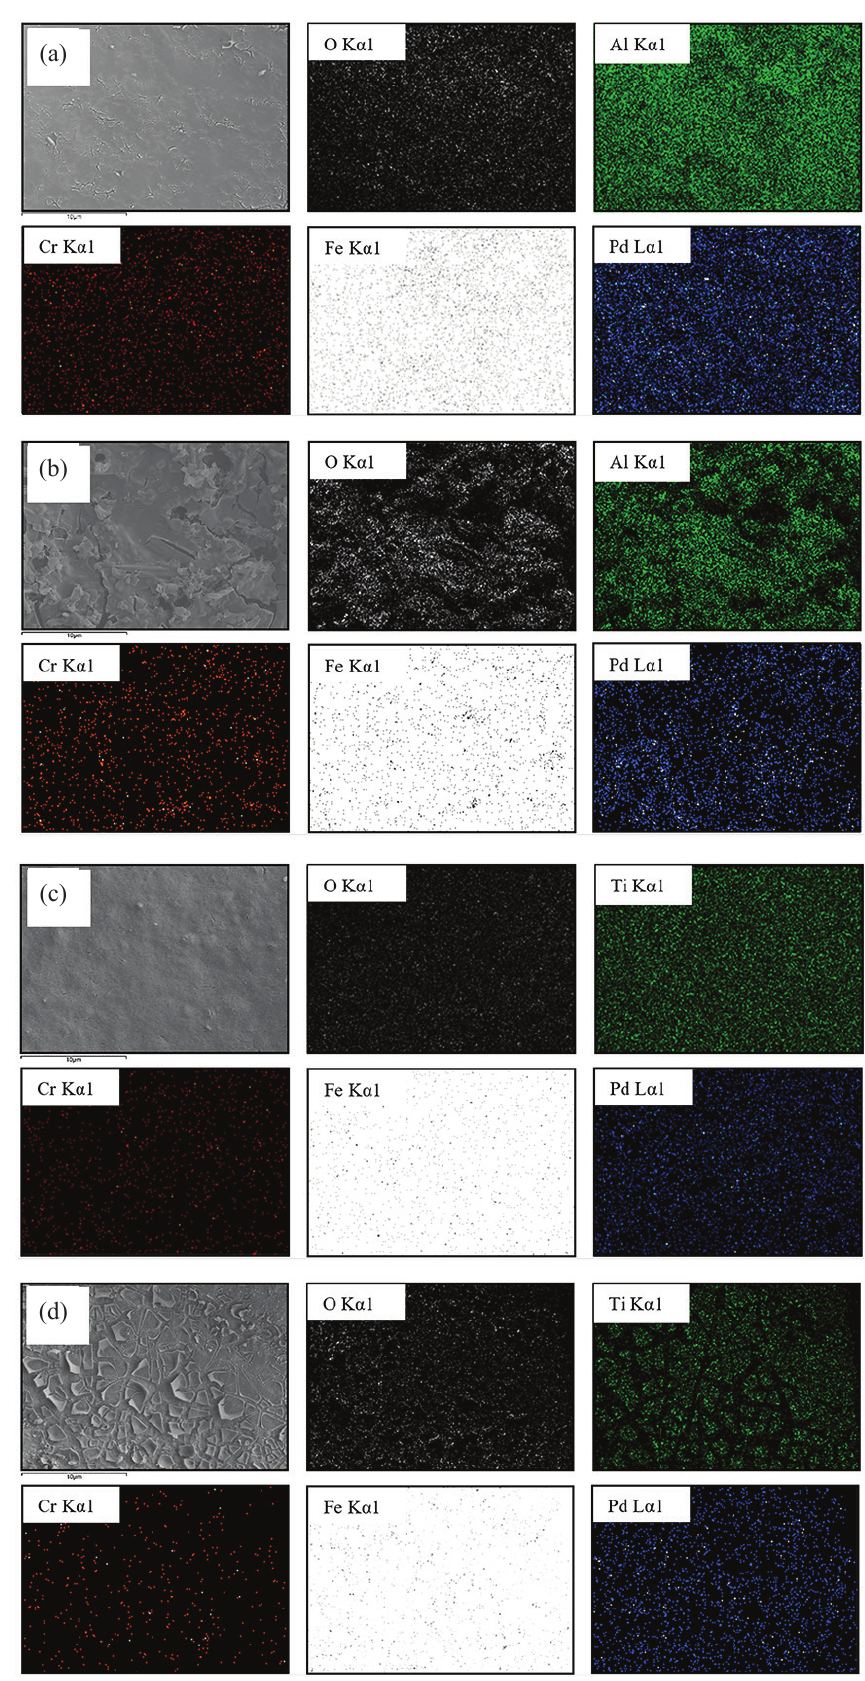
Fig. 5 – SEM images and SEM-EDX mapping of different catalysts on the catalyst plate: (a) Pd/Al (c) Pd/TiO (SUS), and (d) Pd/TiO 2